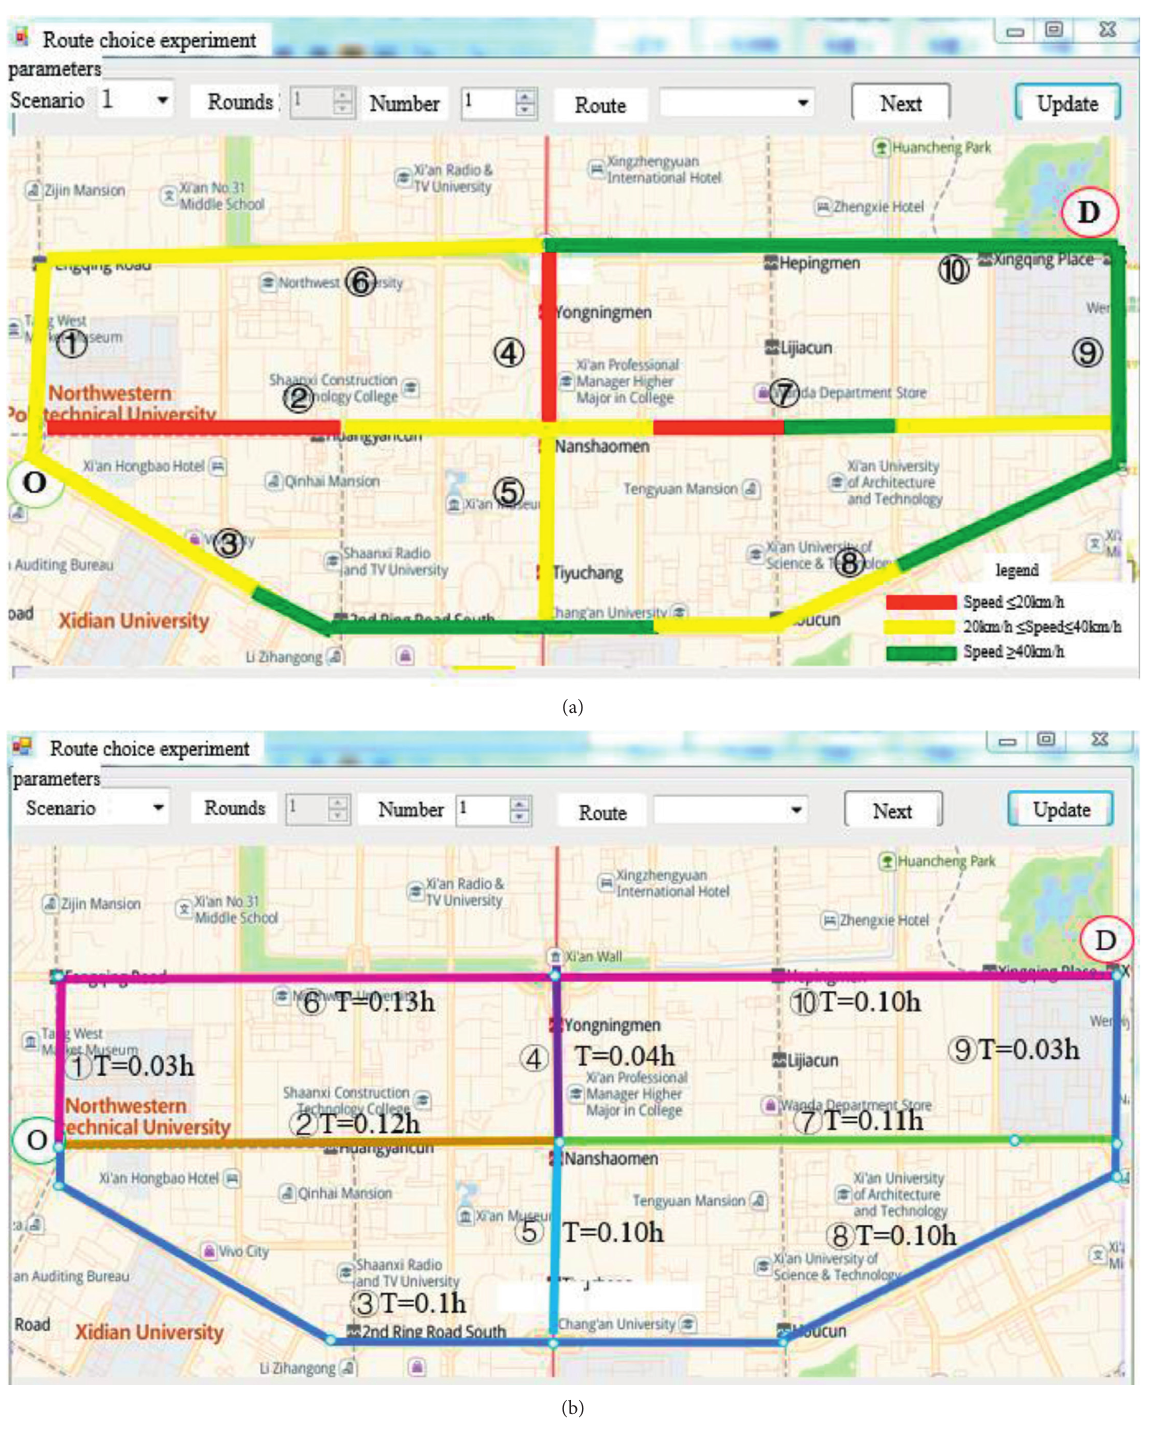
Figure 1: Surfaces of the route choice experiment platform. (a) Scenario 1 and Scenario 3. (b) Scenario 2 and Scenario